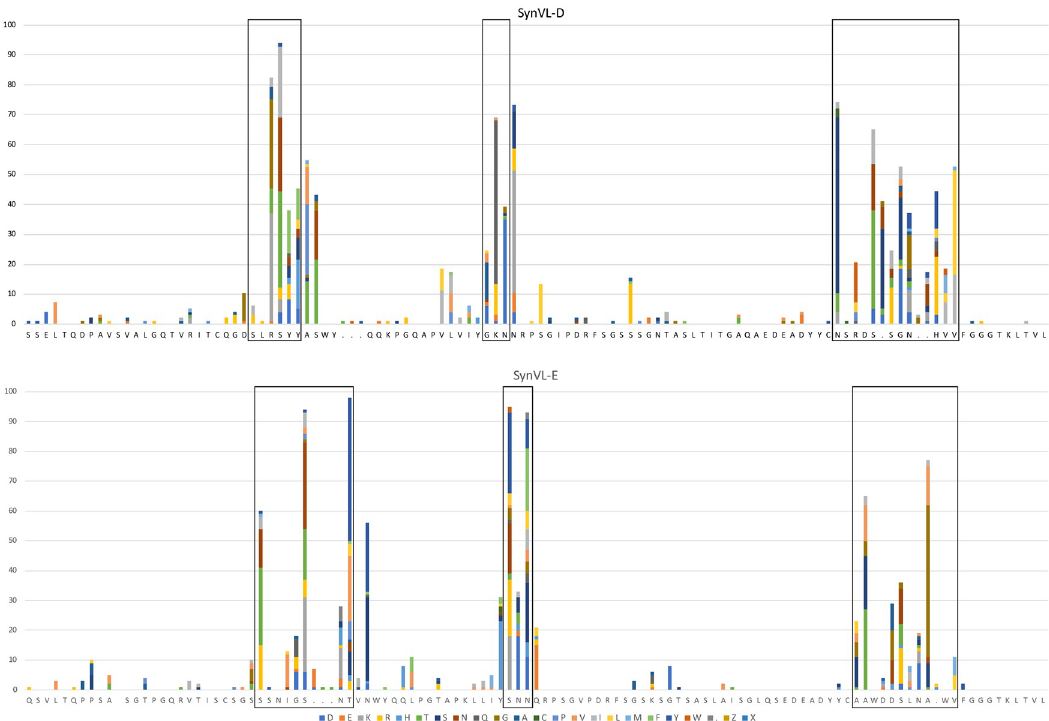
Fig 4. SynVL-D and SynVL-E concentrate amino acid diversity in the CDRs. Sequence diversity is plotted from one hundred clones from both SynVL-D/SynVH-C (top panel) and SynVL-E/SynVH-C (lower panel). The germline sequence for each transgene is shown on the x-axis and amino acid changes at each position are shown as a percentage of the total number of sequences. CDRs (IMGT) are boxed.